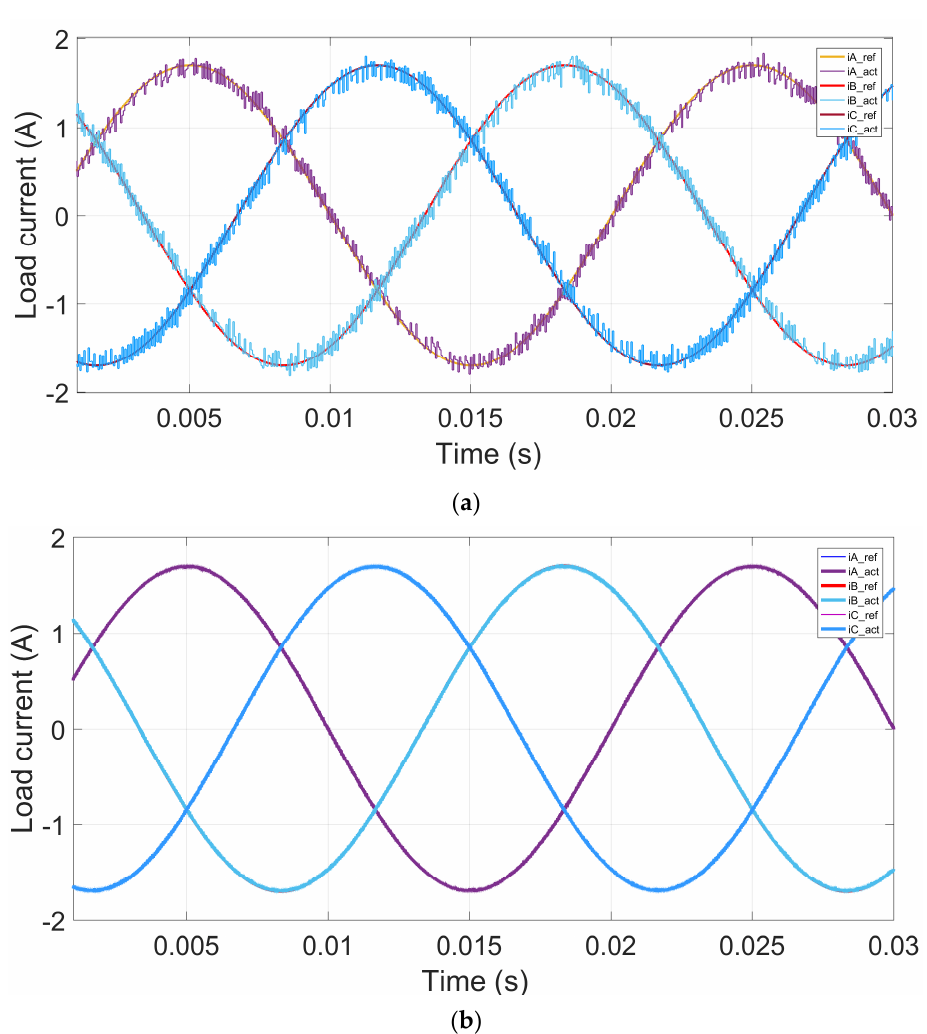
Figure 14. The load current waveforms for different sampling periods: ( a ) T s = 50 μs; ( b ) T s = 5 μs.